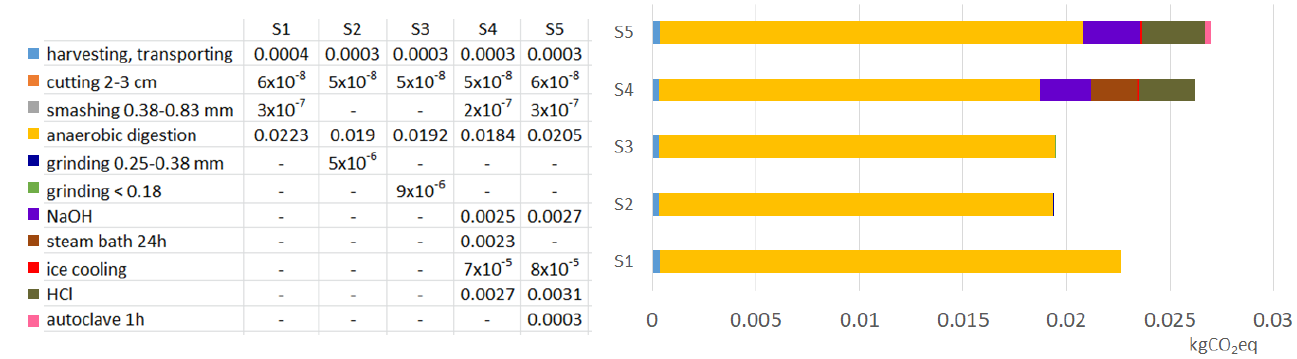
Figure 3. Global Warming Potential per 1 dm 3 of produced methane in the S1 – S5